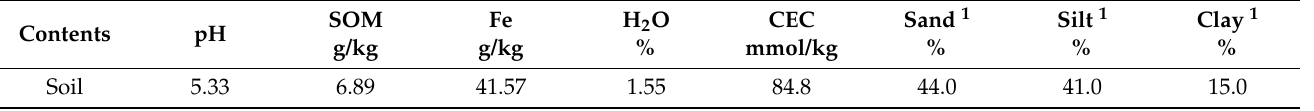
Table 1. The properties of background